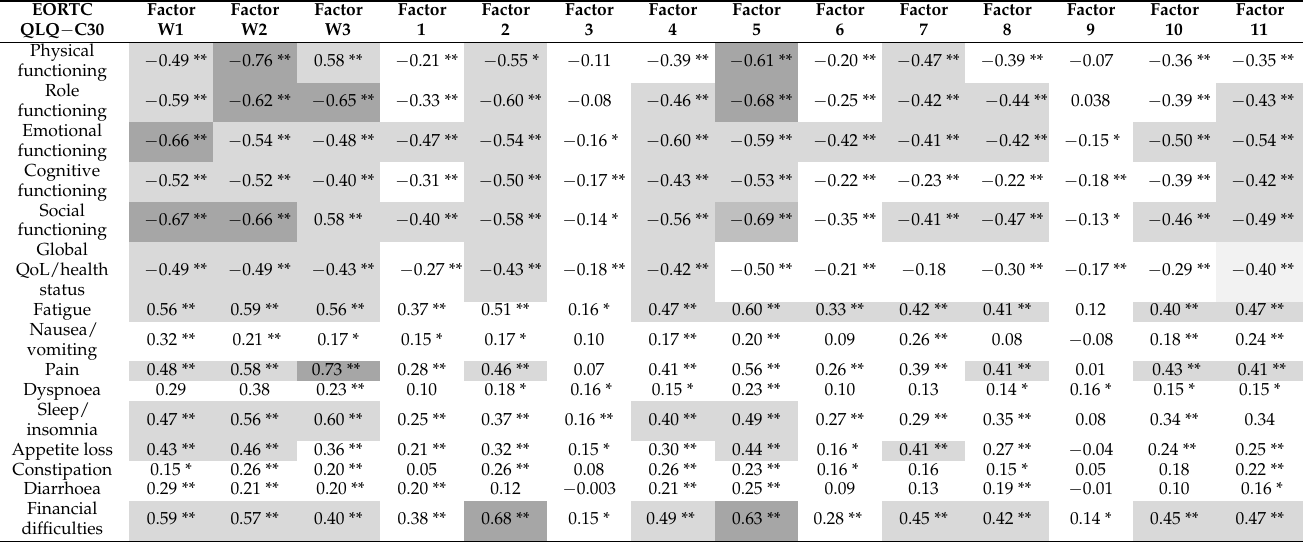
Table 6. Correlations between EORTC QLQ-C30 and scales